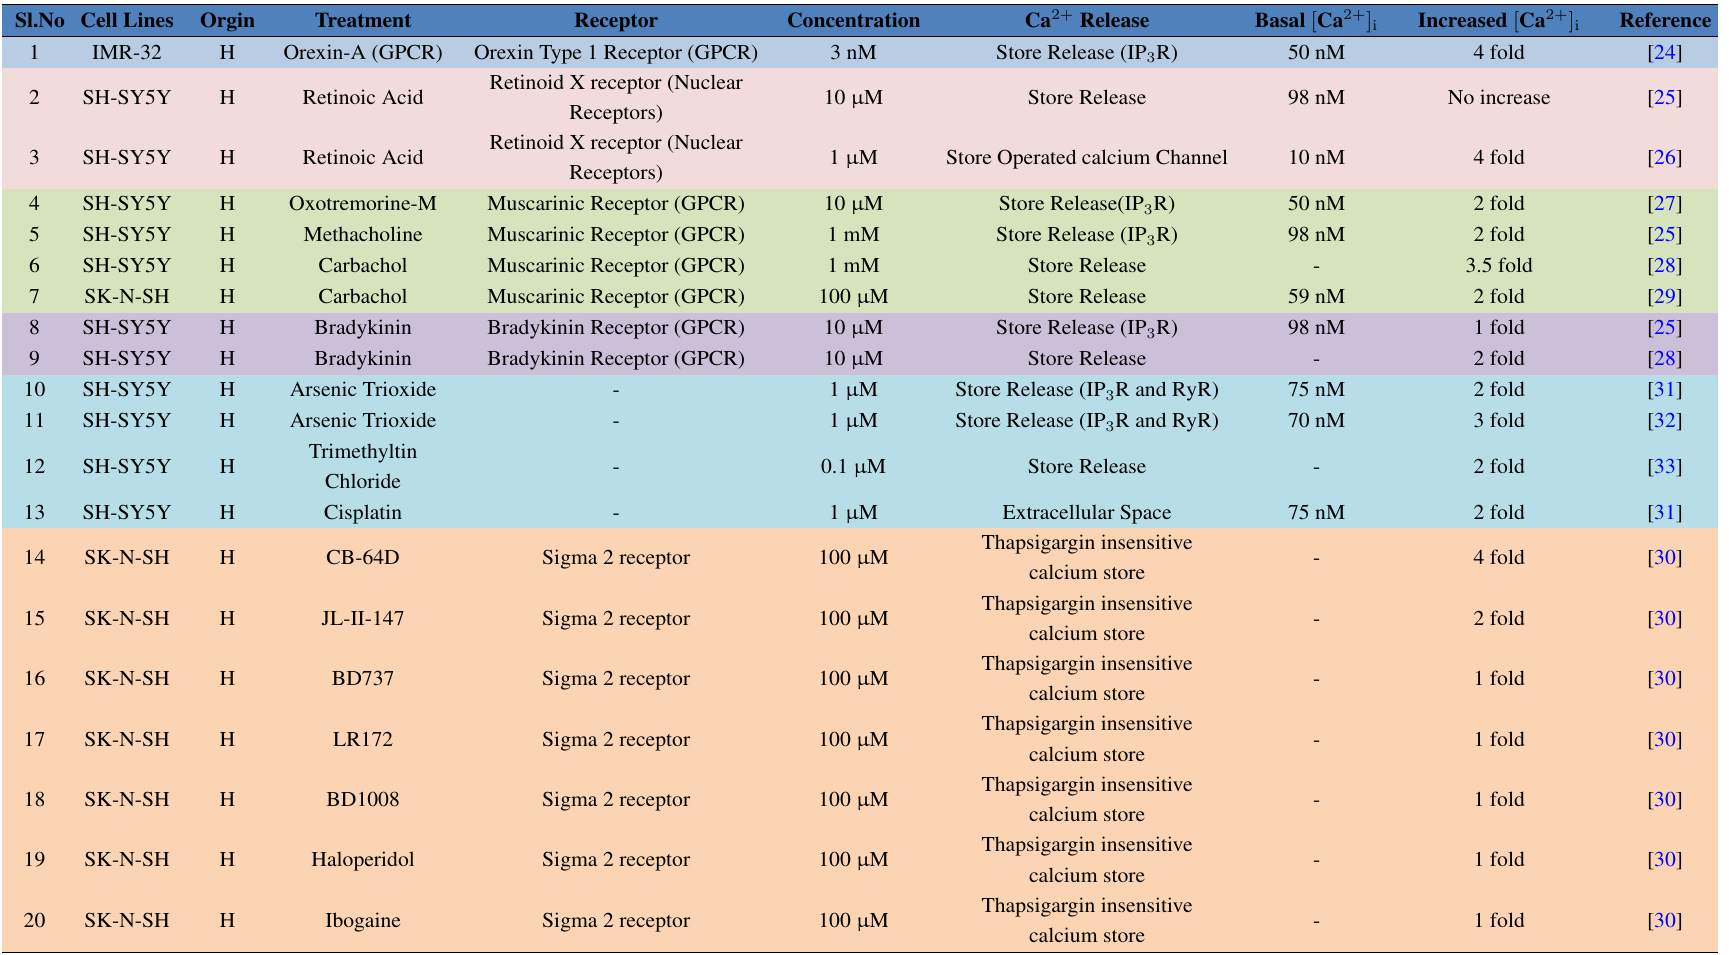
Table 3. Increase of [ Ca 2+ ] in human neuroblastoma cell lines: Color code in the table illustrates different receptors that initiates an i increase of [ Ca 2+ ] in neuroblastoma cell lines of human origin. Two main categories of receptors mentioned include the G-protein i coupled receptor and Sigma receptors (subtypes were not